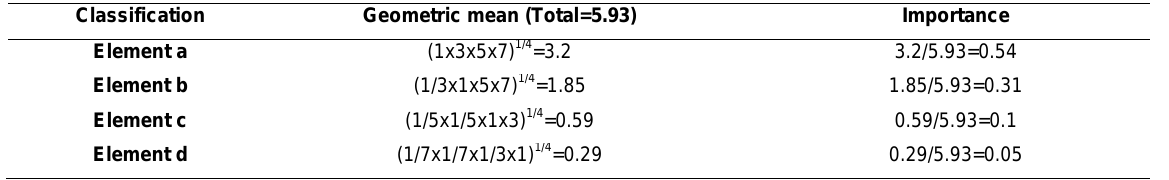
Table 4. Matrix weight estimation for pairwise